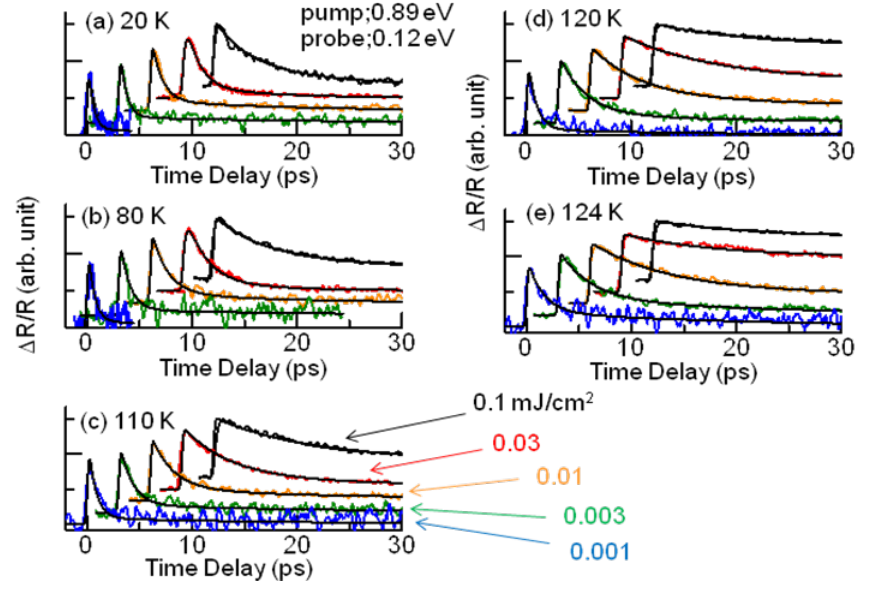
Figure 8. Time evolutions of  R / R at 0.12 eV in α-(ET) of the photoinduced metallic state to the original CO state for various I temperatures are shown. Fitting curves [see the text (3.3)] are also shown as black